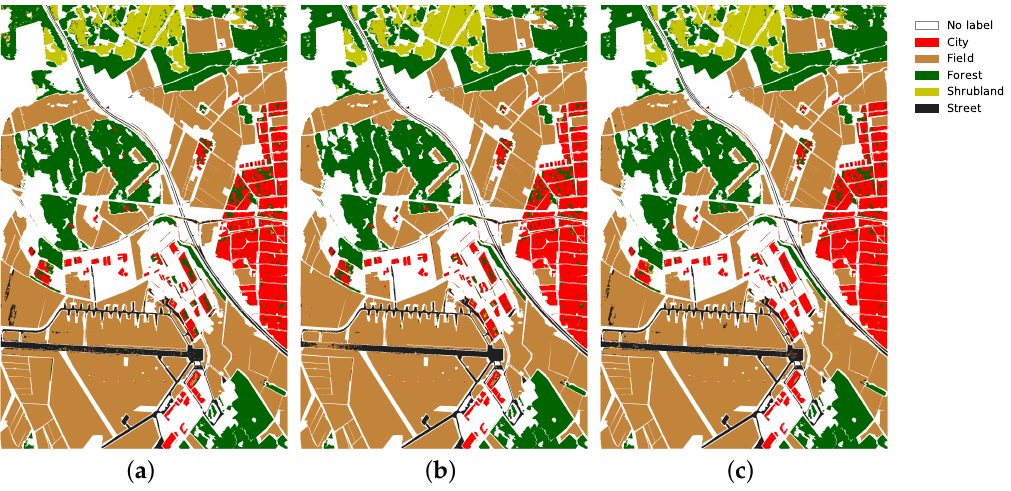
Figure 7. Classification results for best feature sets PCM5, TCM4 and TGR5. ( a ) PCM5, BA = 88.3%; ( b ) TCM4, BA = 88.8%; ( c ) TGR5, BA =